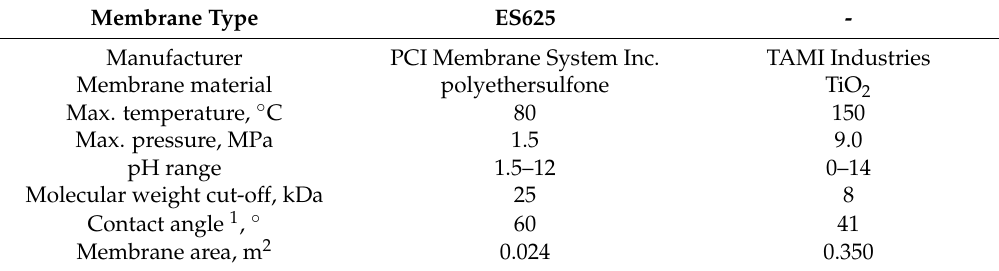
Table 2. Characteristics of the membranes (manufacturer data).